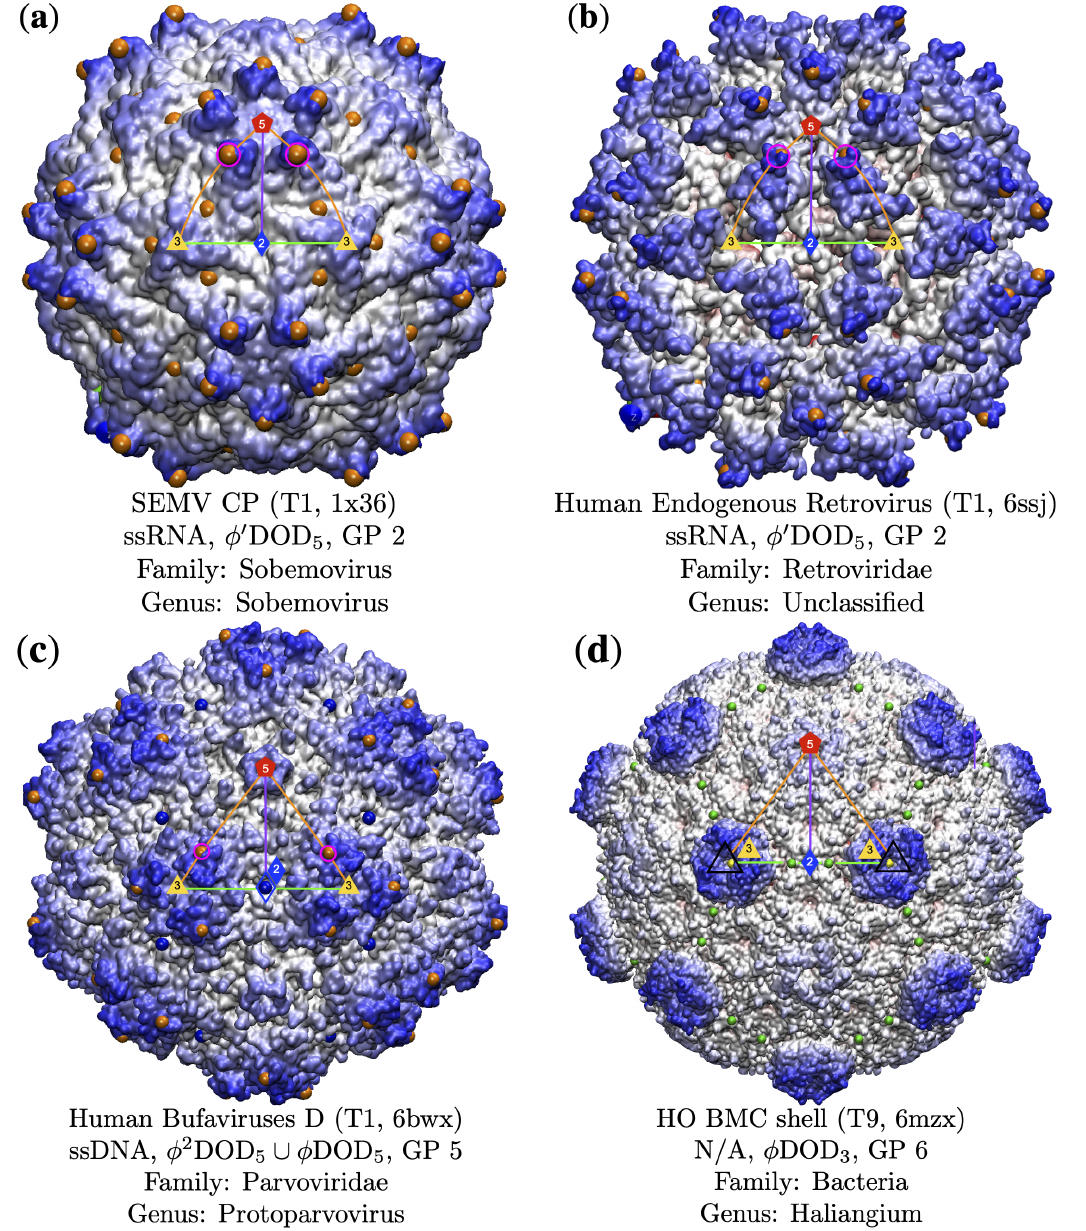
Figure 8. Gauge points along the 5–3 arc (GP 1 to 6). Gauge points which correspond to the key structural protrusions are encircled in pink. Gauge points 2 and 3 are dominated by RNA capsid protrusions (84.6% and 80.0%, respectively). ( a ) Sesbania Mosaic Virus [40] is